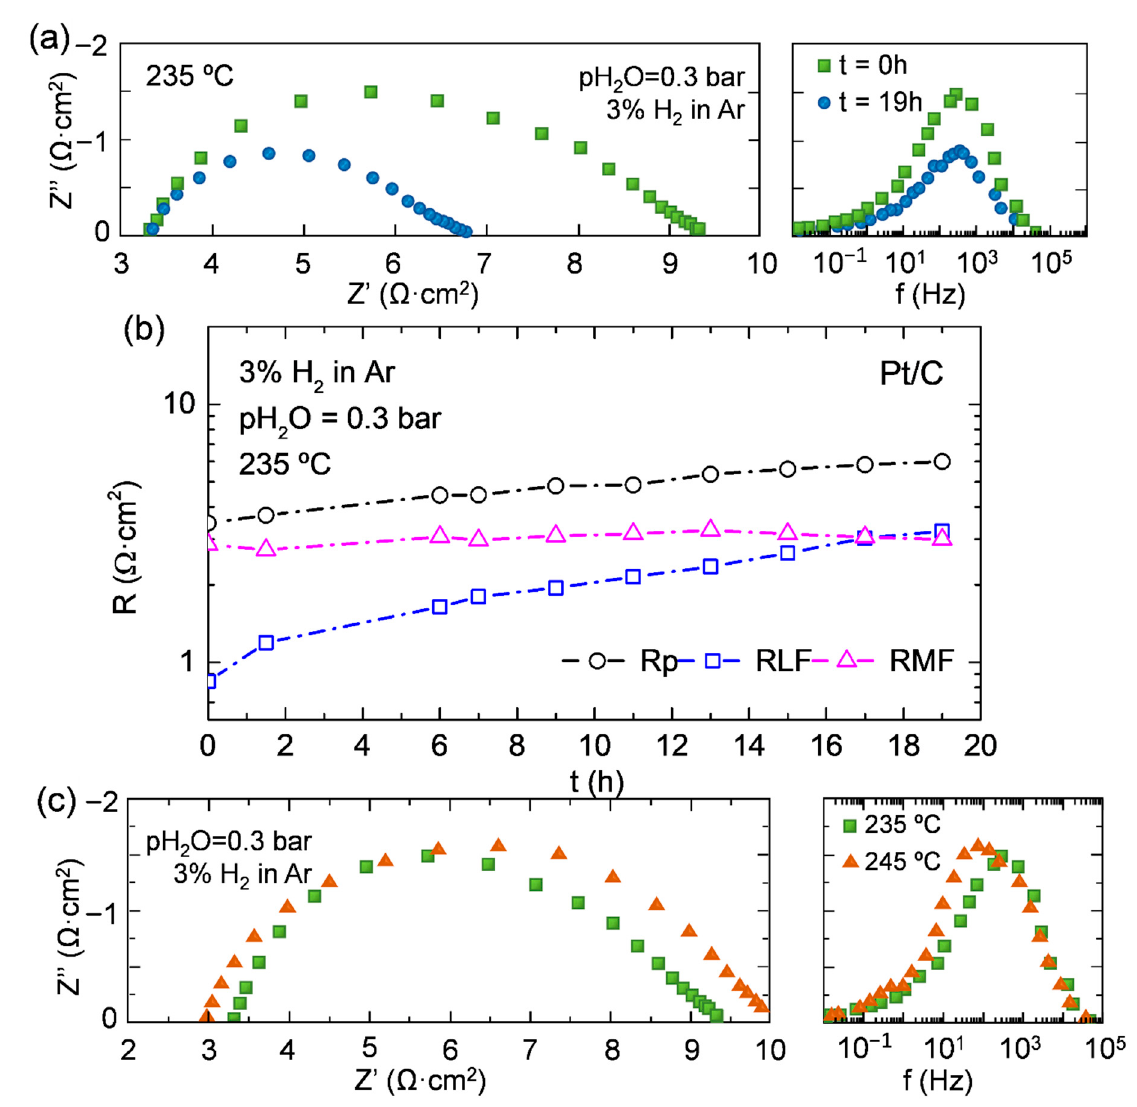
Figure 6. ( a ) Nyquist’s and Bode’s plots of carbon paper and ( b ) resistances obtained from equivalent electrical circuit fitting results of Pt on C paper symmetrical cell at 235 °C as function of time. ( c ) Nyquist’s and Bode’s plots of carbon paper with Pt as a function of temperature.